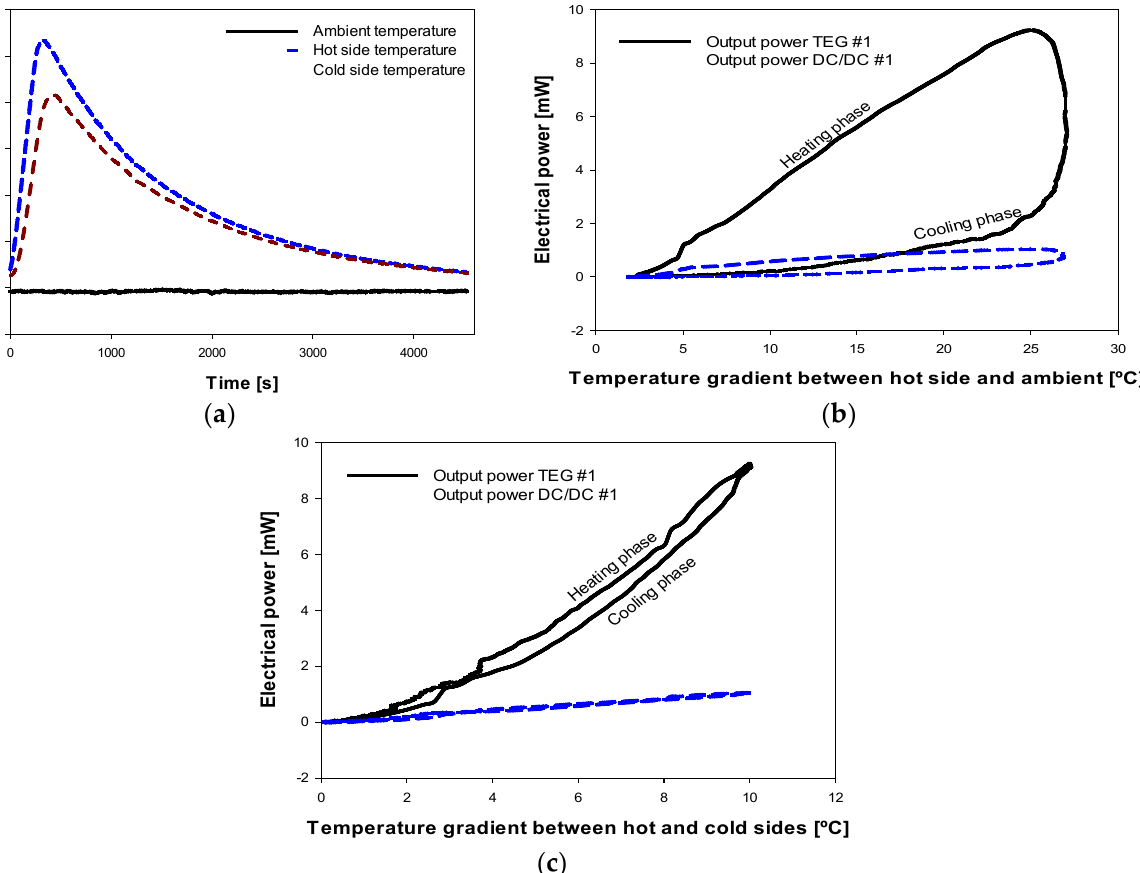
Figure 4. TEG #1 combined with DC/DC converter #1. ( a ) Ambient, hot and cold side temperatures measured by T-type thermocouples. ( b ) Output power of TEG #1 and DC/DC converter #1 versus the temperature difference between the hot and cold sides of TEG #1. ( c ) Output power of the analyzed TEGs and DC/DC converter versus the temperature difference between the hot and cold sides of the TEG #1.